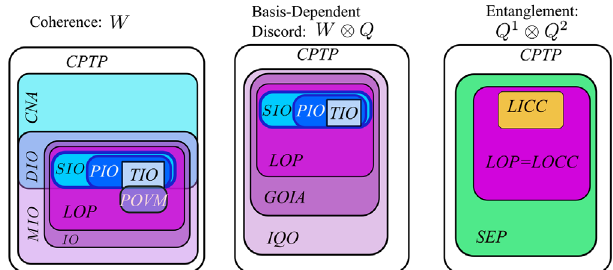
FIG. 4. Venn diagram for the inclusion relations of LOP with selected coherence theories (left), theories of basis-dependent discord (middle), and entanglement theories (right), within general CPTP operations (see Ref. [25] for additional